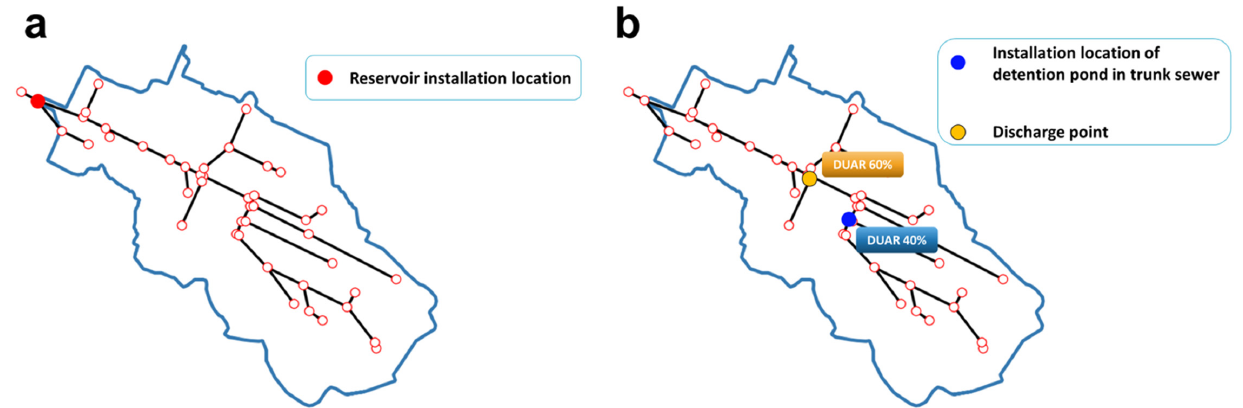
Figure 11. Installation conditions for the reduction facilities in the Gunja watershed. ( a ) Installation location of the underground storage tank and ( b ) installation conditions for the trunk drainage sewer.